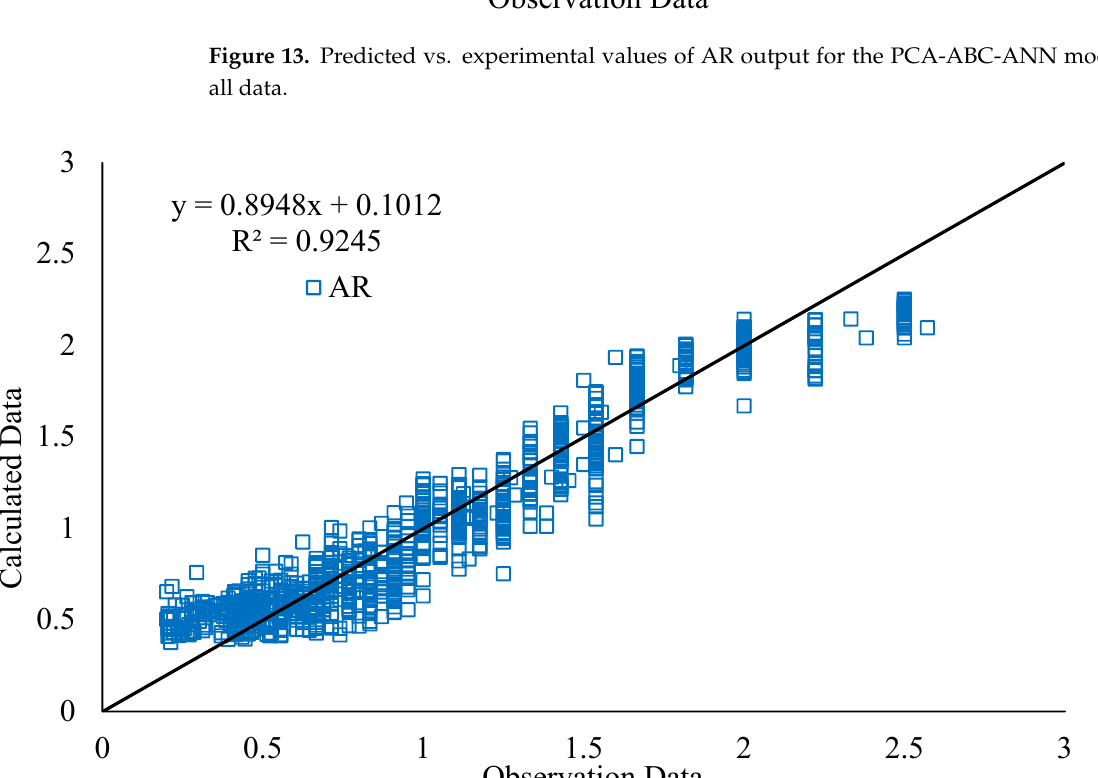
Figure 14. Predicted vs. experimental values of AR output for the PCA-ICA-ANN model using all data.